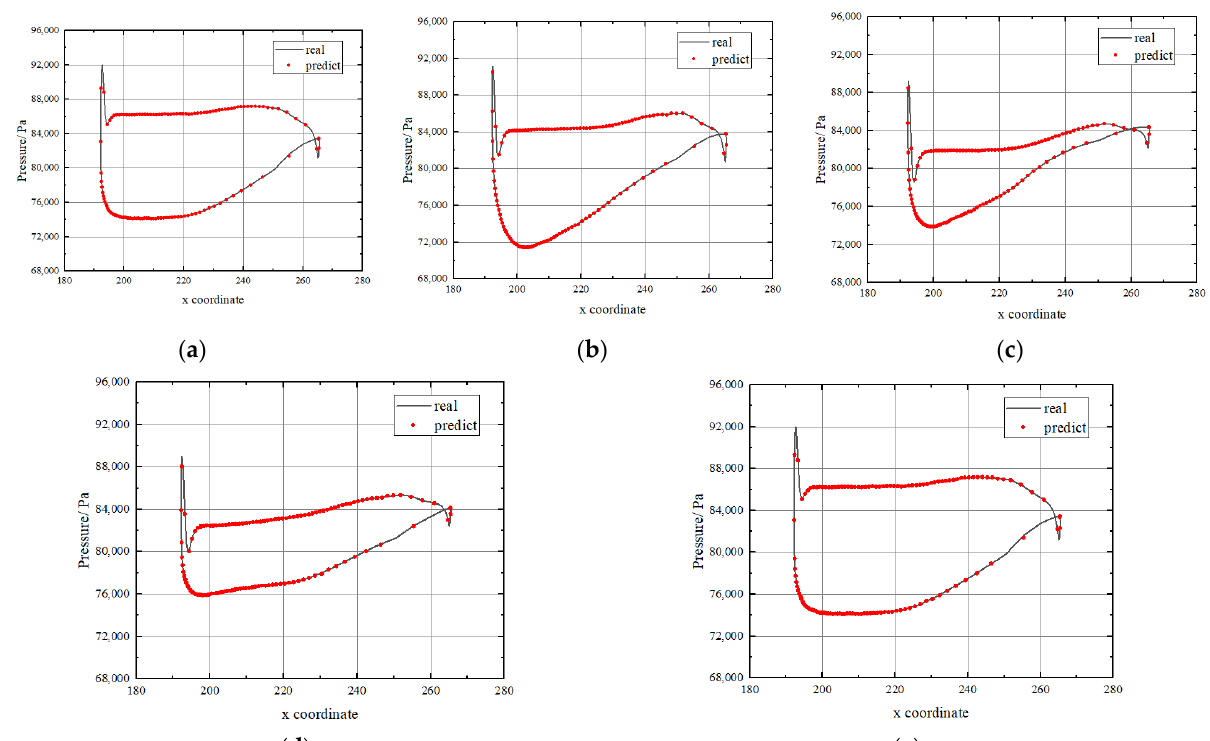
Figure 9. Unsteady pressure on stator surface at 40% span. ( a ) t = 0. ( b ) t = 1/4T. ( c ) t = 1/2T. ( d ) t = 3/4T. ( e ) t = T.